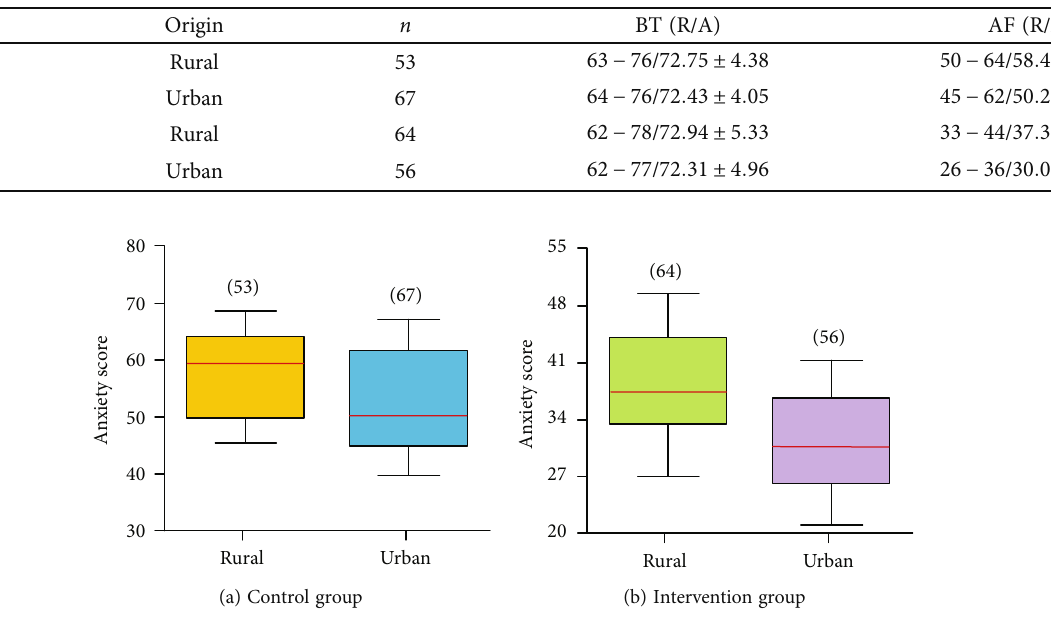
Figure 4: Anxiety evaluation results of college students with di ff erent origins in the control and intervention groups after